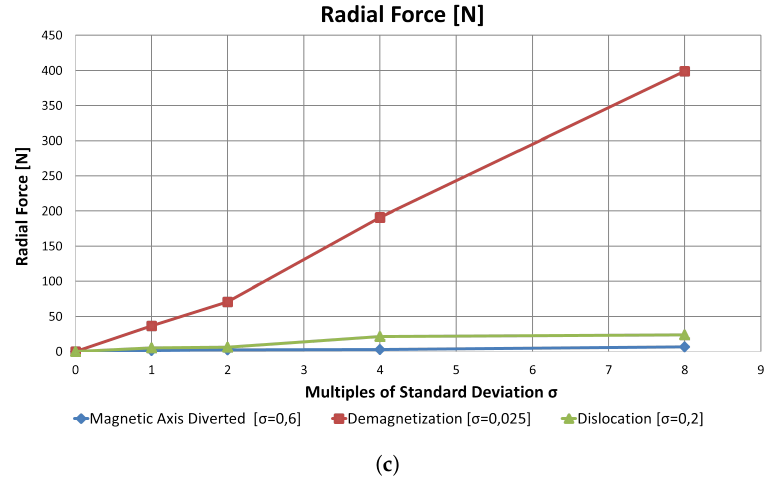
Figure 10. Correlation between severity of magnetic defects and machine performances of slot–pole combination 12-14DL: ( a ) trend of torque ripple; ( b ) trend of cogging torque; and ( c ) trend of radial force for increasing values of magnetic defects. Table 10. Bell curve parameter of permanent-magnet imperfections.